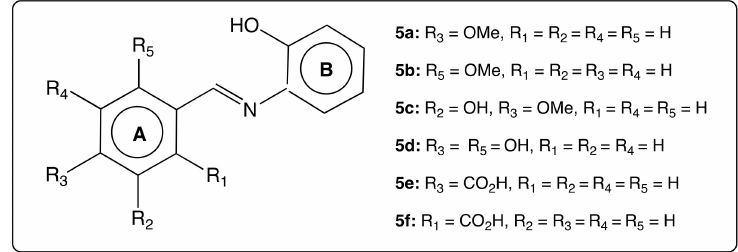
Figure 7. Structure of the compounds of the AZA-ST series 5 (AZA-ST 5 )